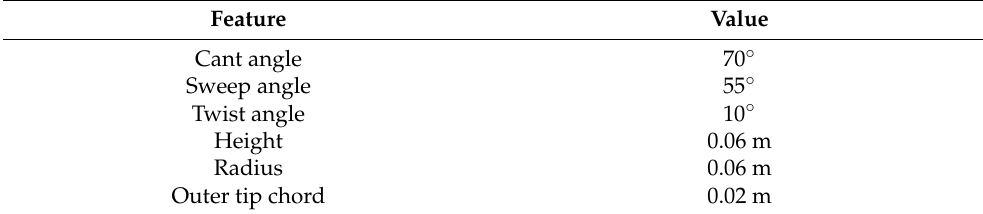
Table 2. Features of the designed winglet.